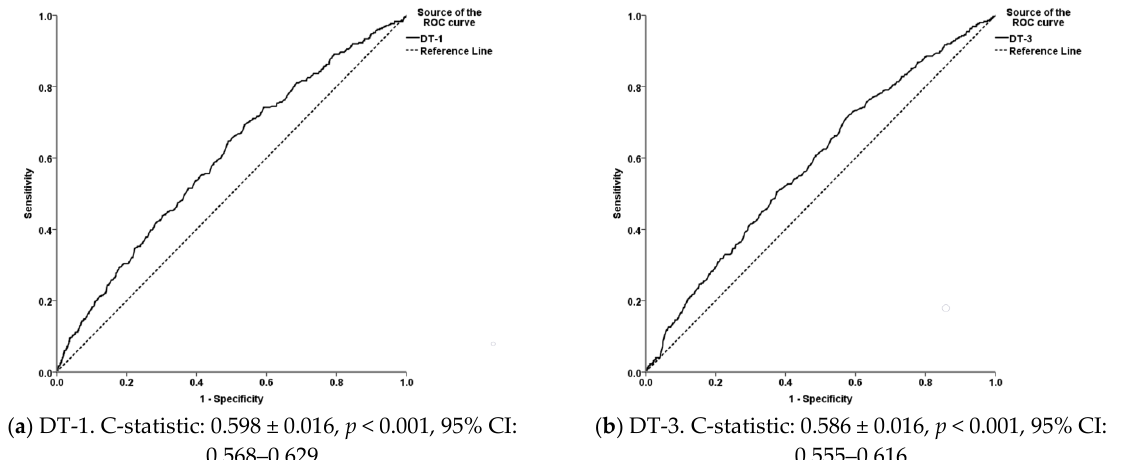
Figure 6. Receiver operating characteristics (ROC) curves illustrating the predicted probabilities and the diagnostic performances of the differences between the ambient temperature and the maximum temperatures at ( a ) the coronary band (DT-1) and ( b ) the hoof sole (DT-3) as regards white line disease. Mean values of the areas under the ROC curves (C-statistic ± standard error), statistical significance, and 95% confidence intervals (CI) are also presented.